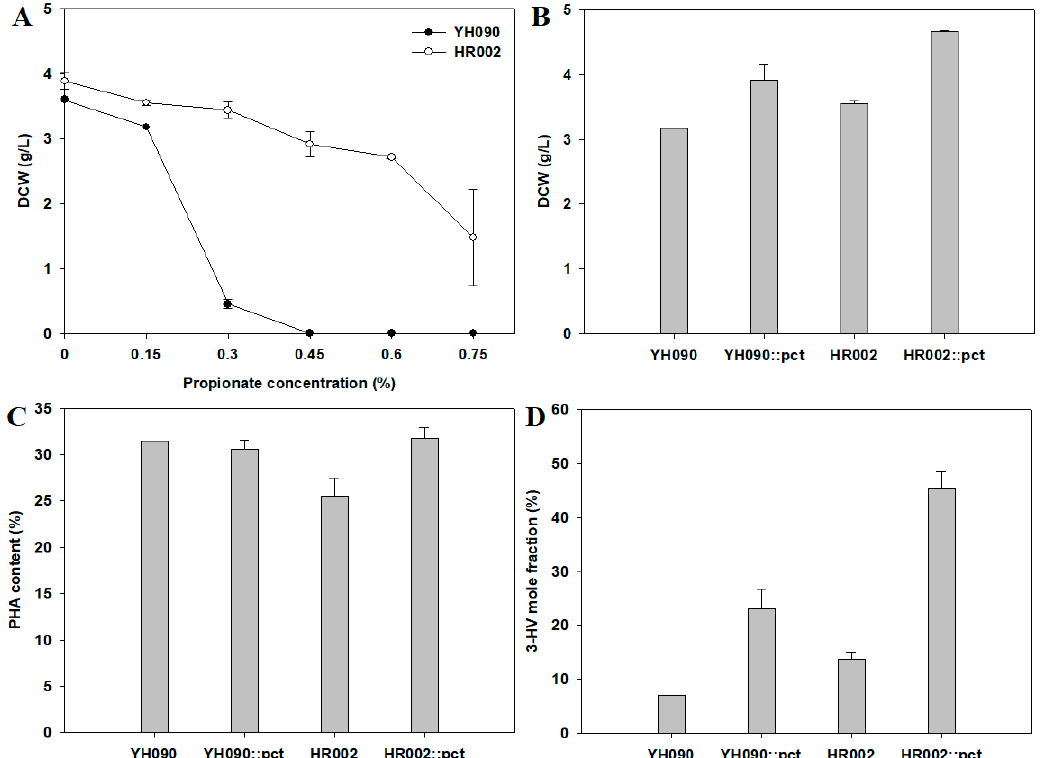
Figure 4. Propionate resistance and the effects of CoA transferase on the high 3-hydroxyvalerate mole fraction of PHBV: ( A ) DCW (dry cell weight, g/L) according to the concentration of propionate; ( B ) DCW (dry cell weight, g/L); ( C ) PHA content (wt/wt %); and ( D ) 3-hydroxyvalerate monomer content (mol %). Cell cultivation was conducted for 72 h in M9 minimal medium containing 2% glucose and different concentrations of propionate (0–0.75% in ( A ); and 0.15% in ( B – D )). Error bars represent the standard deviations of two replicates.